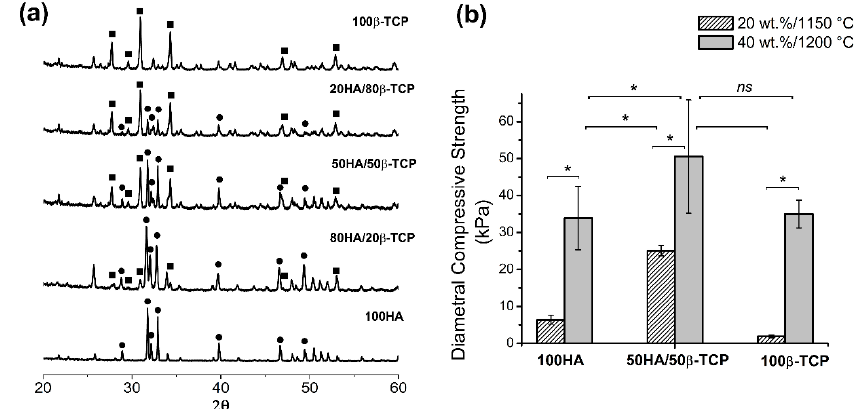
Figure 9. Characterization of scaffolds made of pure HA, pure β -TCP or biphasic HA/ β -TCP. ( a ) XRD patterns of scaffolds with 40 wt.% fabricated at 1200 ◦ C, - (cid:4) - β -TCP, - • - HA; ( b ) Diametral compression strength at different conditions. * p < 0.05.